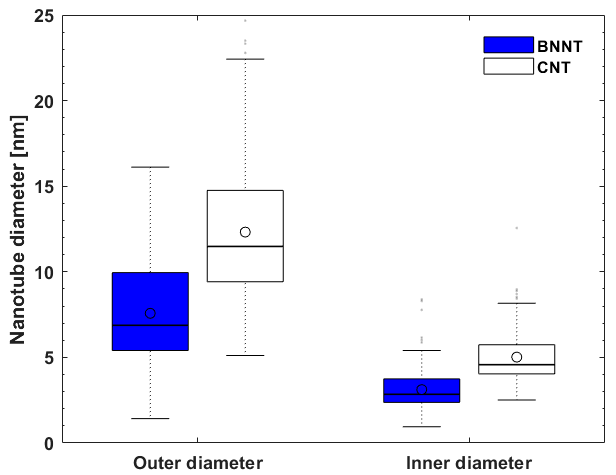
Figure 4. Box plots for the outer and inner nanotube diameters of the BNNTs and CNTs as measured by low- and high-magnification TEM images; the circle marker and the bold line correspond to the mean and median values, respectively. Table 1. Fractal dimension parameters deduced from SEM images (Figure 2).